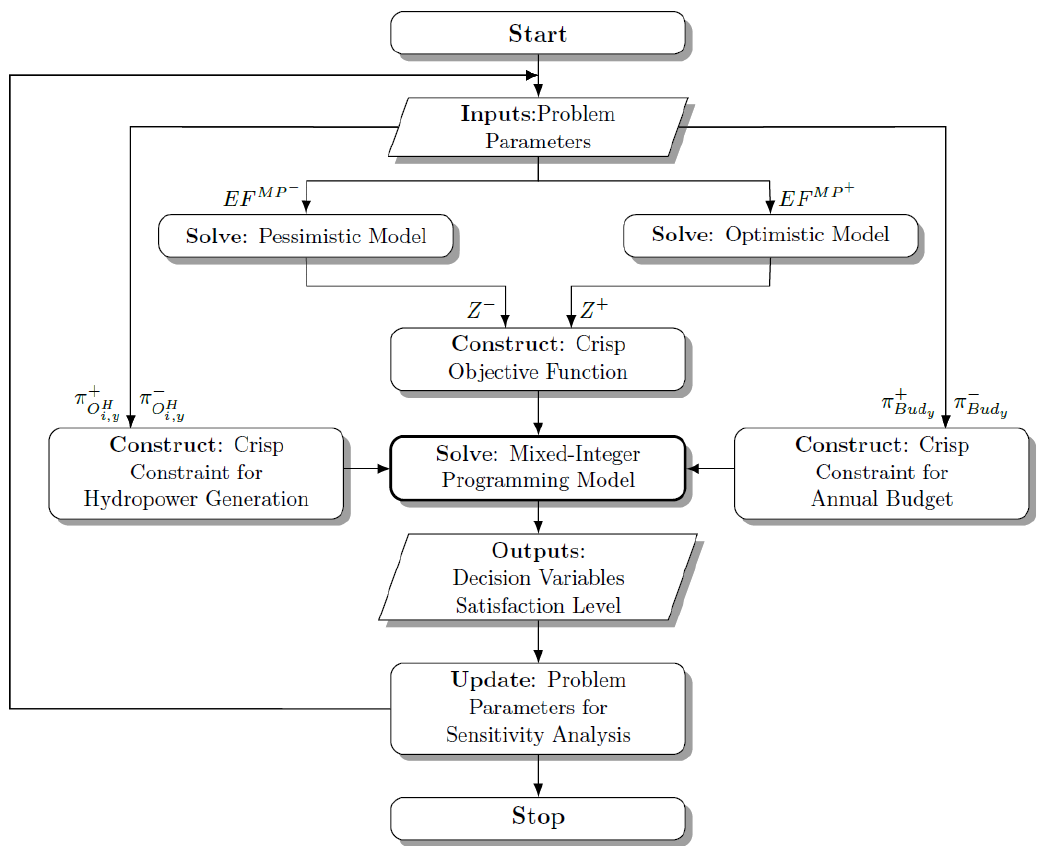
Figure 5. The flow chart of the solution algorithm.